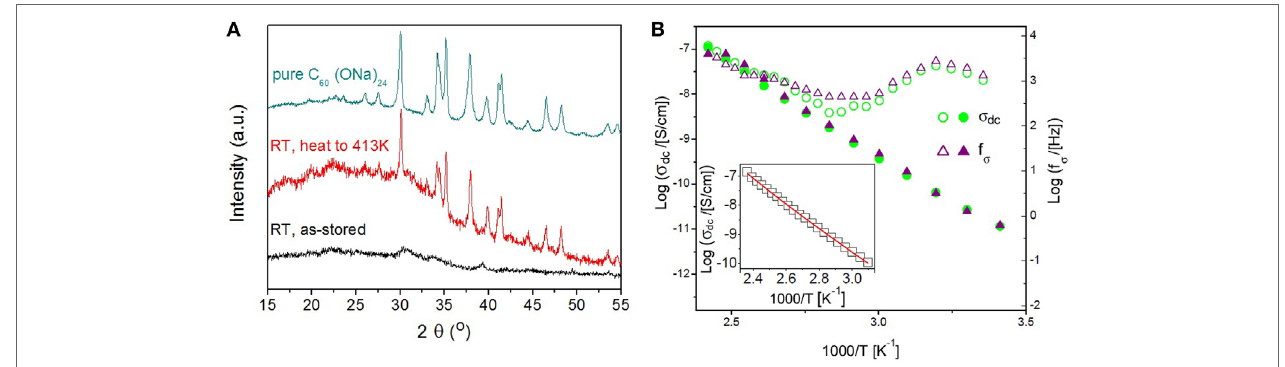
FiguRe 2 | (A) Room-temperature X-ray powder diffraction patterns of hydrated (lower curve) and anhydrous (middle curve) C 60 (OH) 24 fullerenol, in the 2 θ range between 15° and 55°. The anhydrous material is obtained from the hydrated one by heating to 413 K. For comparison, the room-temperature pattern of pure C 60 (ONa) 24 (upper curve) is also shown. (B) Arrhenius plot of σ dc (circles) and of the conductivity relaxation frequency f σ (triangles)—see the text for details—measured upon heating an initially hydrated fullerol sample (empty markers) and subsequent cooling of the same, now anhydrous, sample (filled markers). Data between 283 and 413 K are shown. Inset: Arrhenius plot of σ dc for anhydrous fullerol, and fit with the Shklovskii-Efros variable-range hopping model. Adapted with permission from Mitsari et al. (2017). Copyright 2017 American Chemical